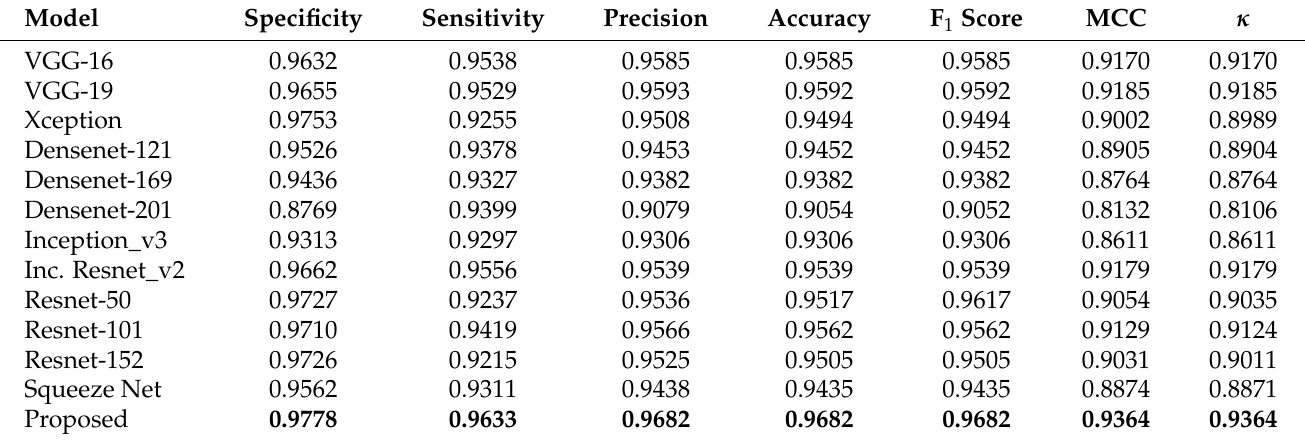
Table 3. Performance comparison of the proposed method and other deep learning models on NIH Malaria dataset. The best results in each metric are marked in